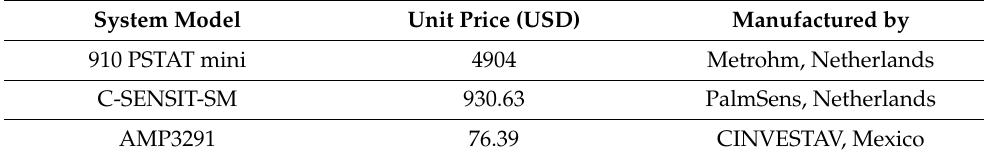
Table 2. Cost comparison between AMP3291 and similar systems.